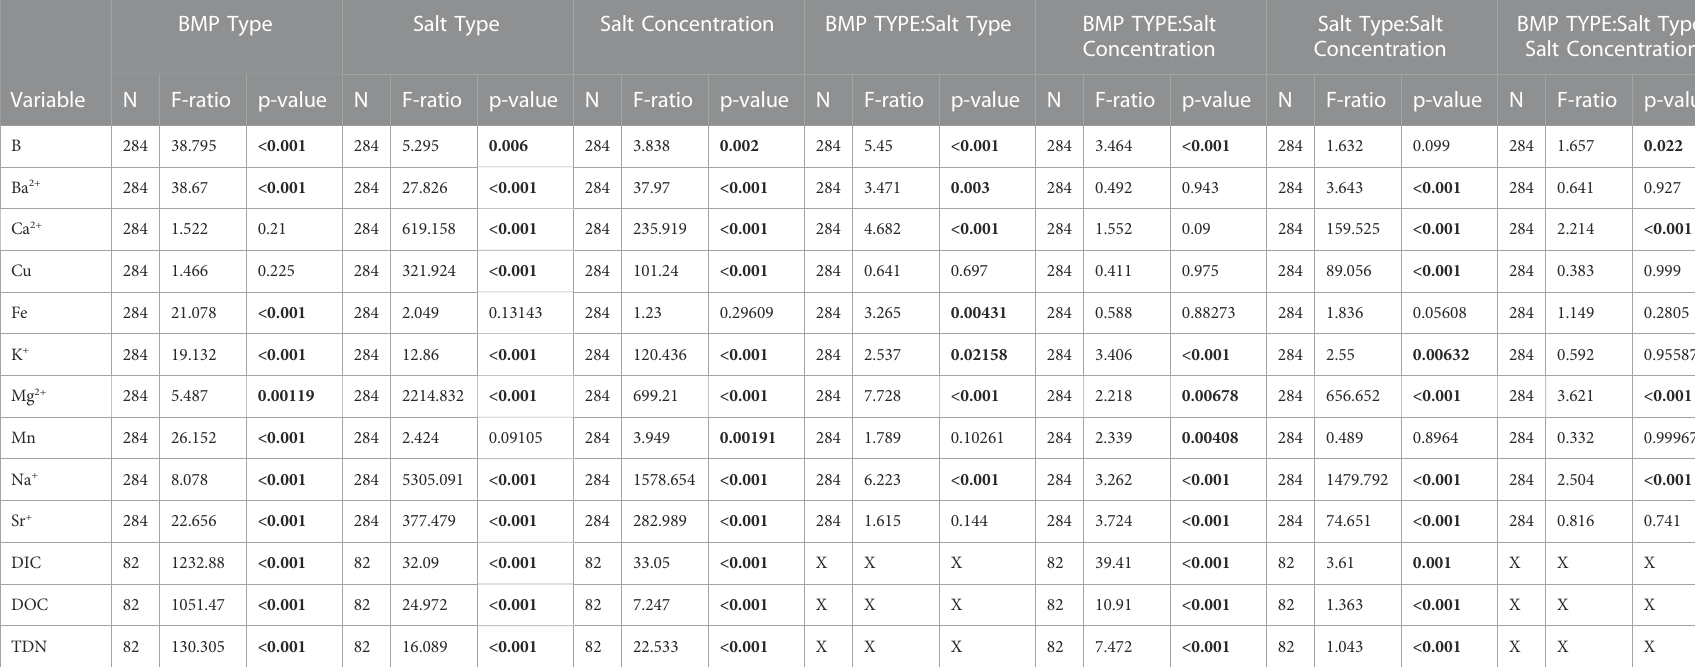
TABLE3Three-way ANOVAanalysis dataassessingmaineffects ofstormwater BMPtype,salttypeandsalt concentration onresultingelemental mobilization. Majorandtraceelementalanalysis isshown,alongwithdissolved inorganic carbon (DIC), dissolved organic carbon as non-purgeable organic carbon (DOC), and total dissolved nitrogen (TDN). Signi fi cant p values are denoted by bold